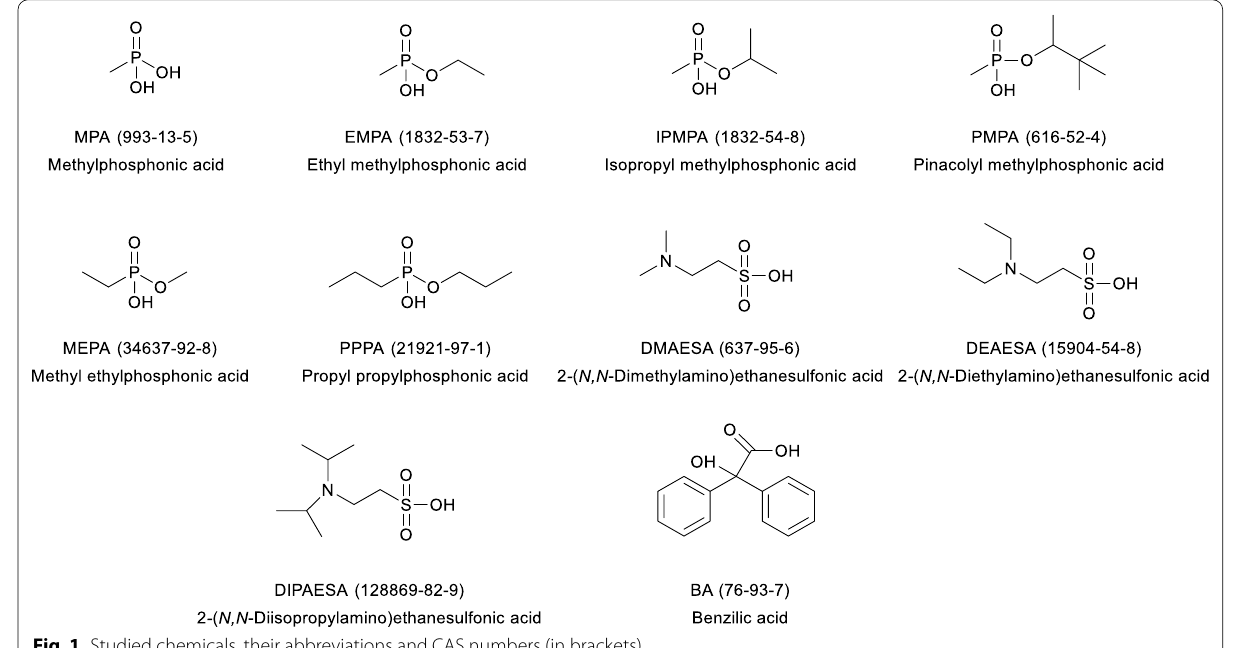
Fig. 1 Studied chemicals, their abbreviations and CAS numbers (in